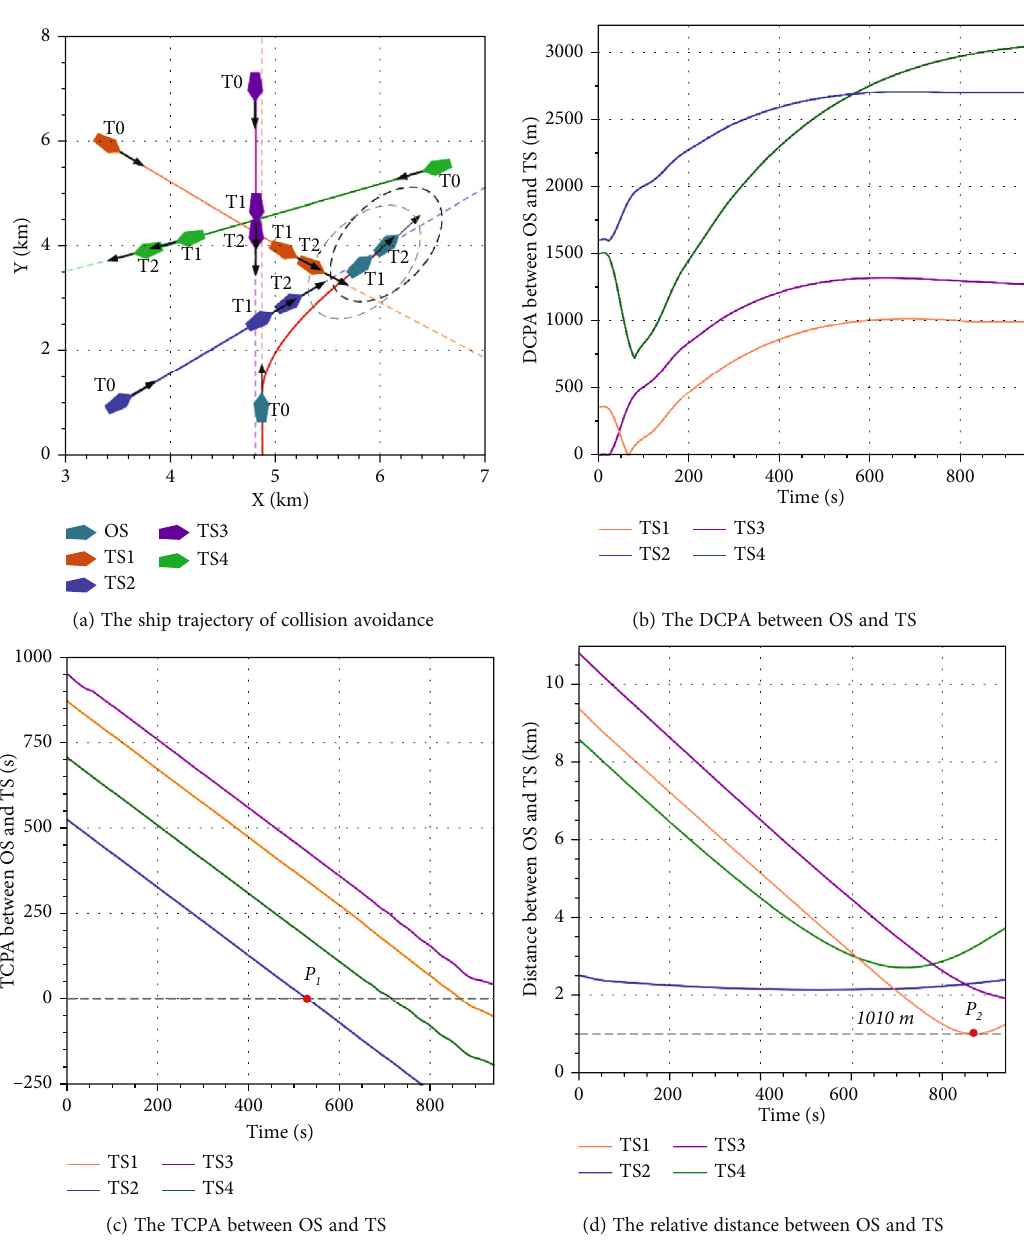
Figure 16: The simulation results under multiship encounter situation. Table 10: Collision avoidance information of simulation